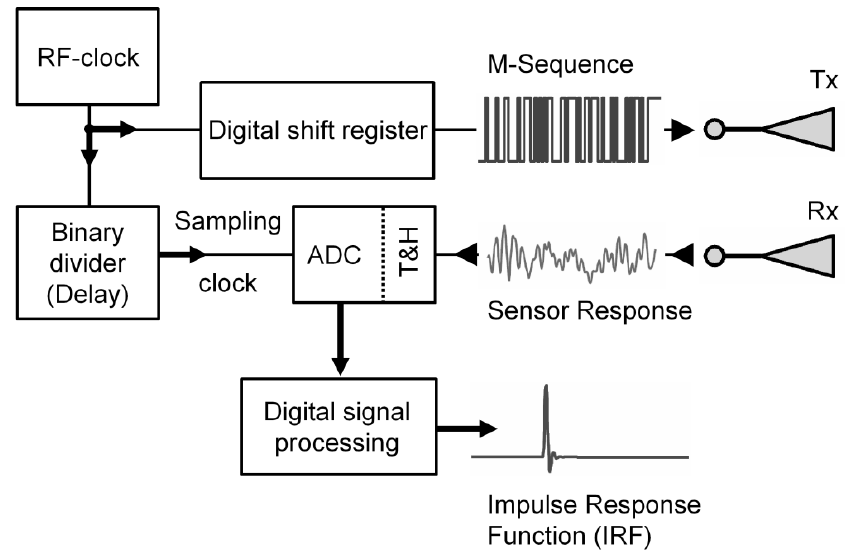
Figure 2. Basic structure of the measurement head in block schematics based on the maximum length binary sequence (M-sequence) [12,13]. T&H: Track and hold circuit. Tx, Rx: transmit and receive